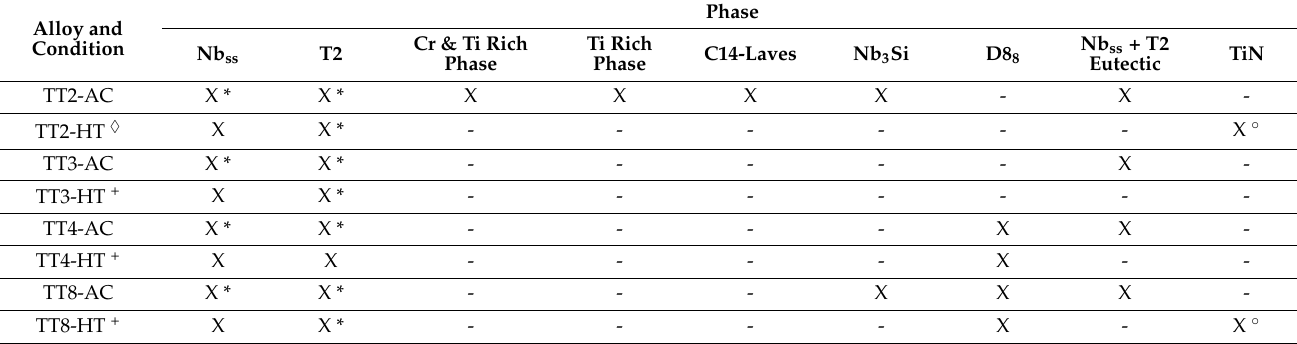
Table 4. Phases in the as cast (AC) and heat-treated (HT) alloys according to the XRD and EPMA data. Alloy and